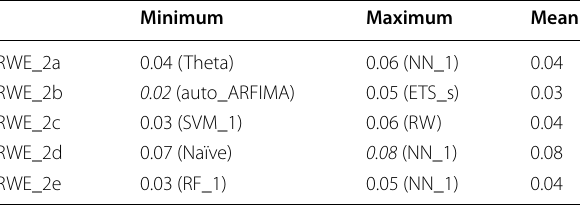
The minimum of the minimum values and the maximum of the maximum values are in italic